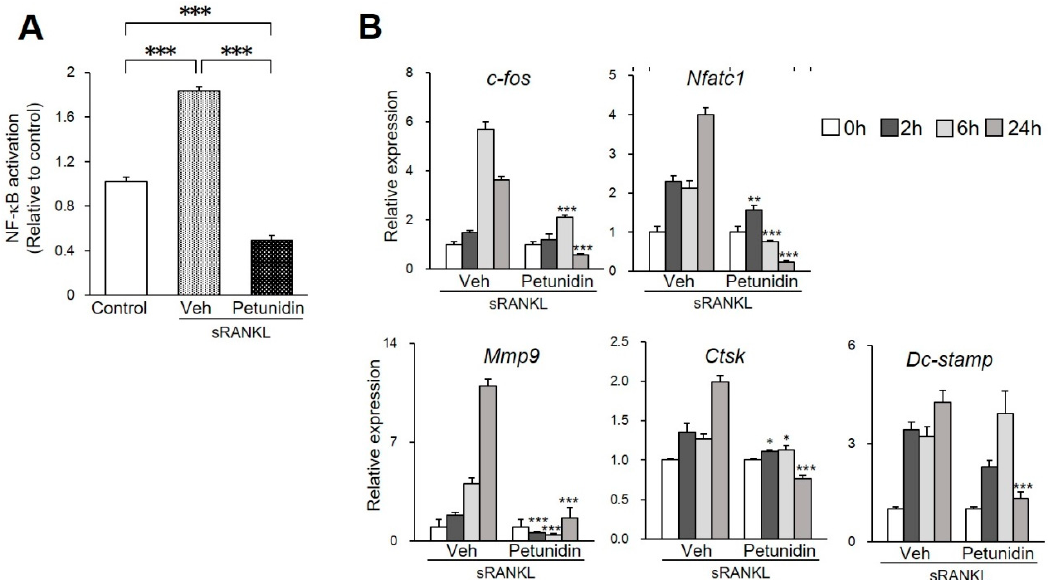
Figure 2. E ff ects of petunidin on the osteoclastogenesis. ( A ) NF- κ B p65 subunit DNA-binding activity examined in RAW264.7 cells using the TransAM ® assay kit. ( B ) Quantitative real-time RT-PCR analyses of c -fos, Nfatc1, Mmp9, CtsK and Dc-stamp mRNA expression. The levels of mRNA expression were normalized with that of Gapdh . RAW 264.7 cells were cultured with or without 50 µ g / mL of petunidin. Data are representative of three independent experiments and values are expressed in mean ± SD ( n = 4). * p < 0.05, ** p < 0.01, *** p < 0.001 vs. vehicle (Veh) in the same culture period.